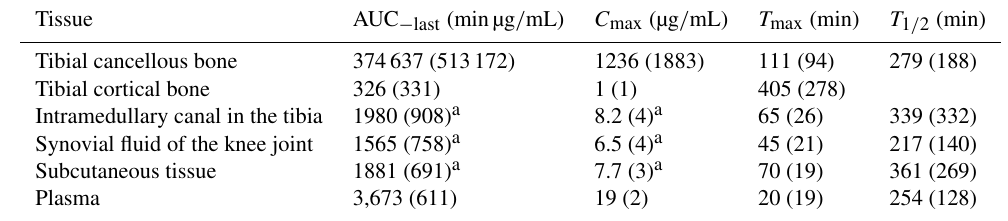
Table 1. Key pharmacokinetic parameters given as a mean (SD) for tibial cancellous bone, tibial cortical bone, the intramedullary canal in the tibia, the synovial fluid of the knee joint, subcutaneous tissue, and plasma.